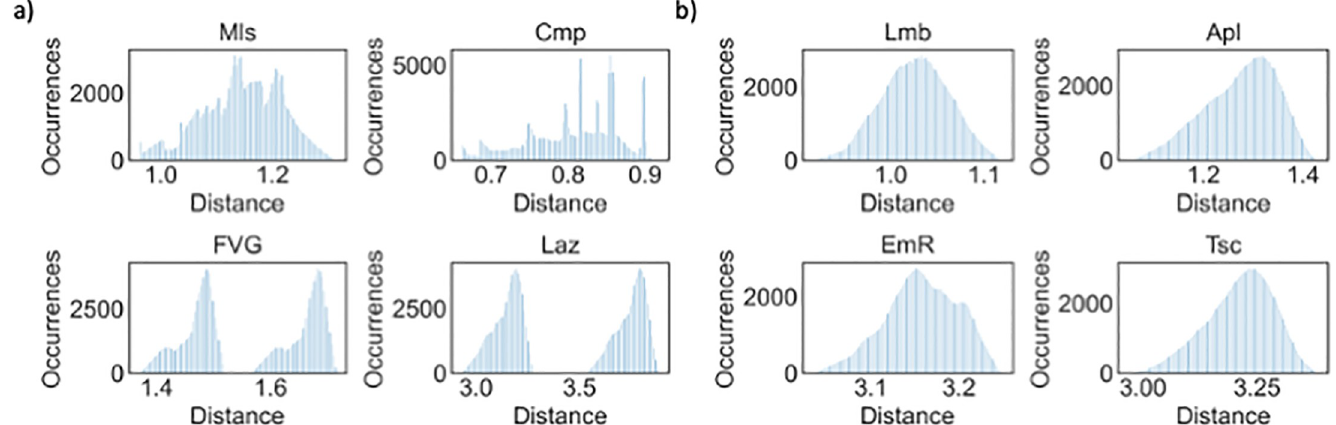
Fig 2. Distributions for (a) Mls, Cmp, FVG, and Laz; and (b) Lmb, Apl, EmR, and Tsc Number of occurrences in the simulation against cumulative distance between estimated and reported expenditures.